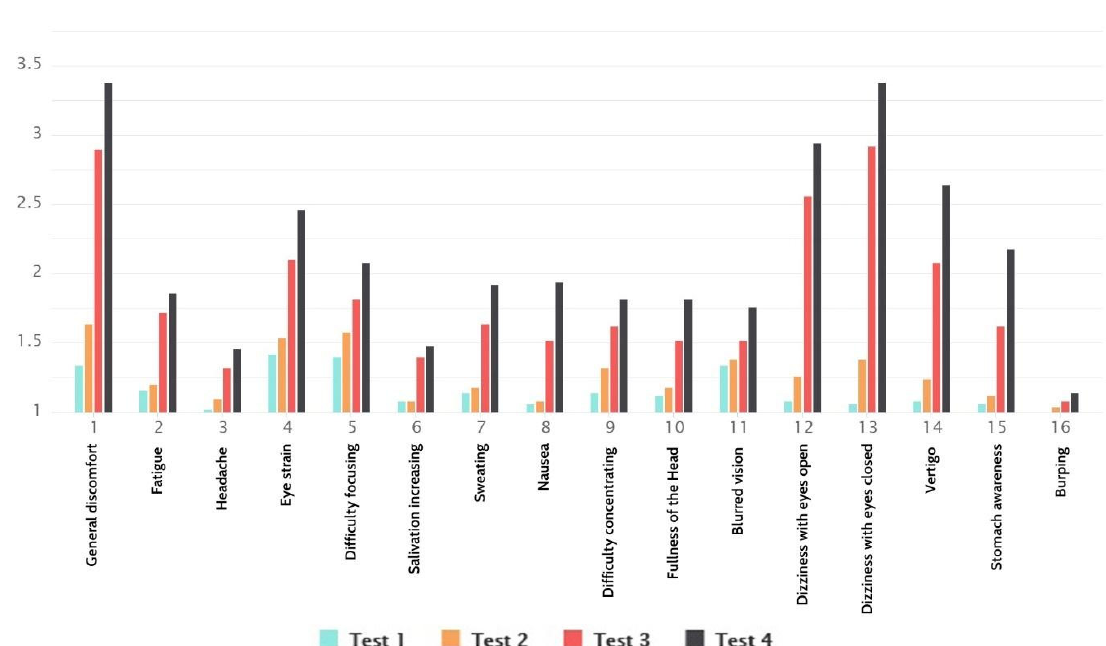
Figure 8. Disorientation results.